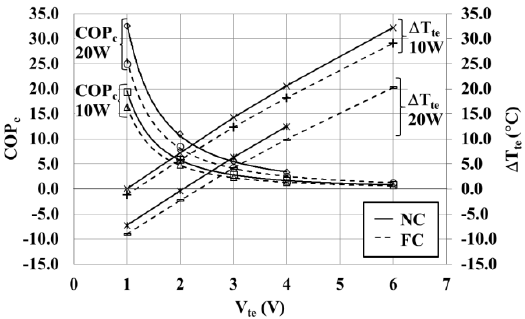
Figure 13. Coefficient of performance COP c and temperature difference Δ T te for the FHS ‐ TE